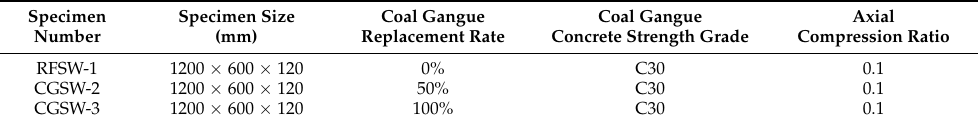
Figure 3. Concrete aggregate.